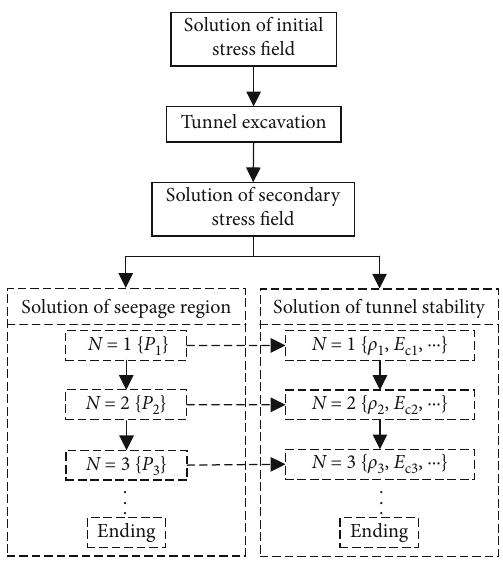
Figure 11: Calculation fl ow of the wetting-drying